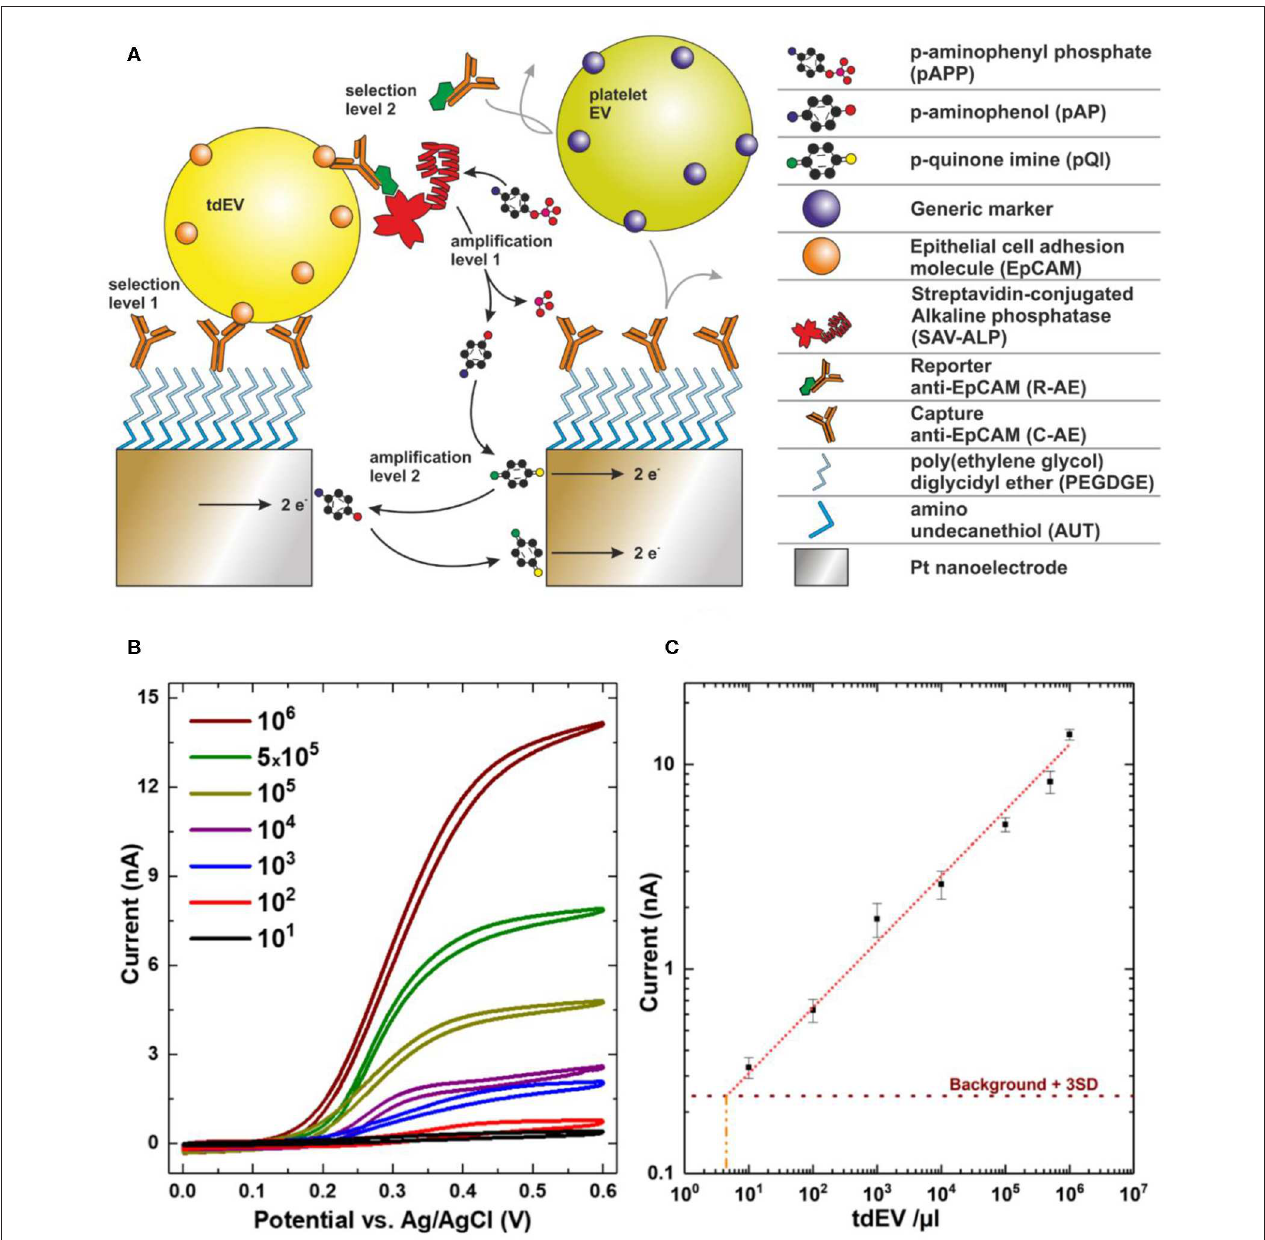
FIGURE 9 | Electrochemical detection of extracellular vesicle (EV) samples. (A) Scheme showing selective capture and in-situ labeling of EVs followed by enzymatic amplification of redox species and redox cycling. (B) Cyclic voltammograms recorded for a very wide range of EV concentrations. (C) Recorded current at 0.4V for varying concentrations showing linear response over six orders of magnitude. Image adapted from Mathew et al.